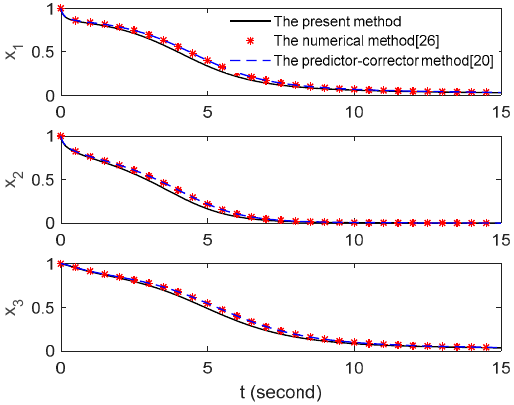
Figure 6. Numerical solutions of x 1 , x 2 and x 3 for the case of h = 0.01.